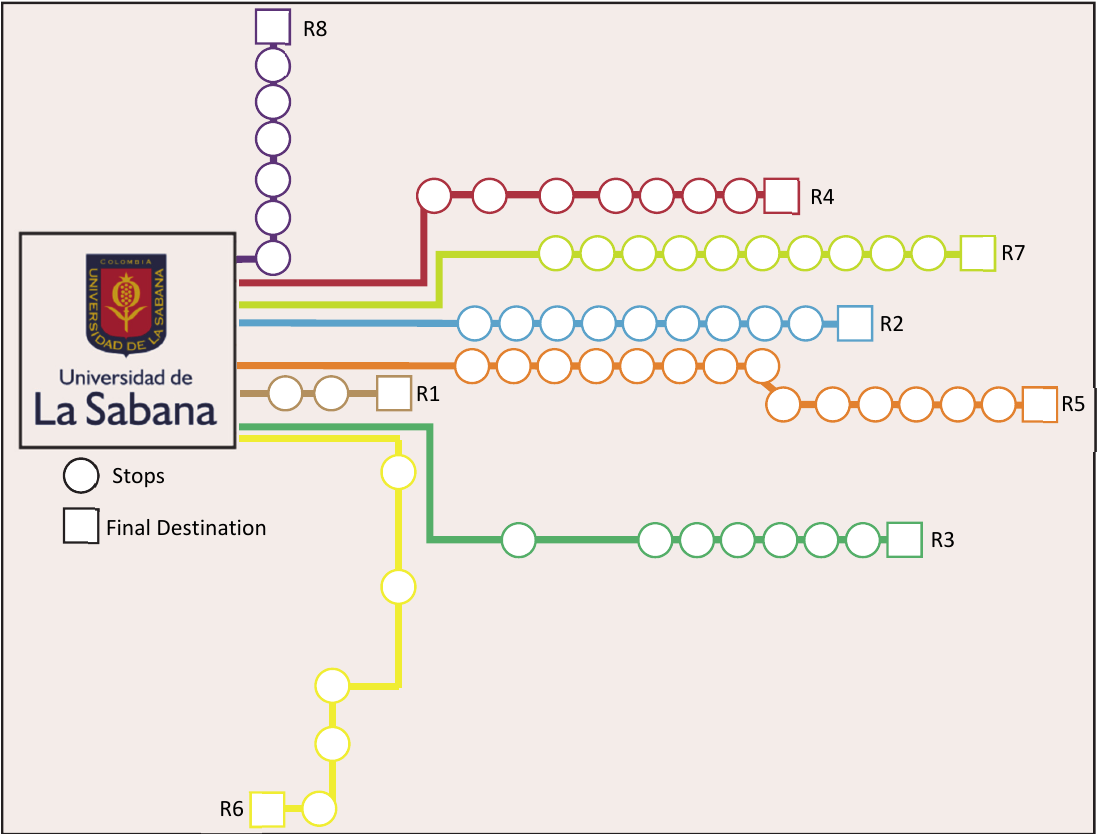
Fig. 3 . Available transportation routes (Universidad de La Sabana,